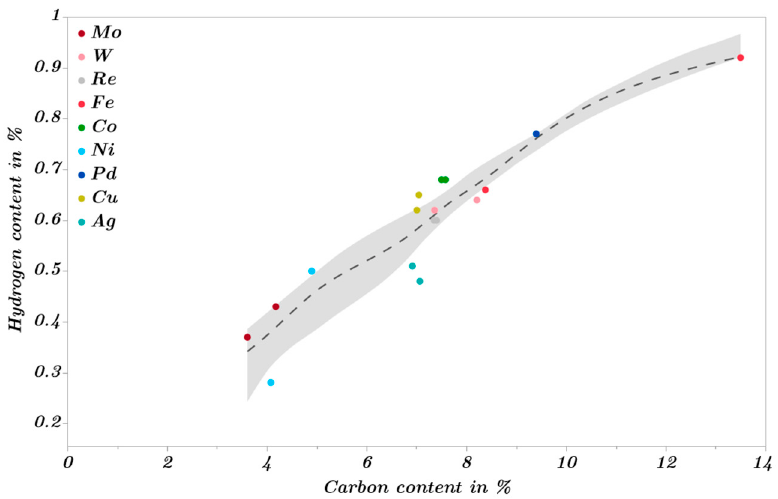
Figure 22. Dependence of the hydrogen and carbon mass fractions determined by CHNS analysis. The dashed smoothing is based on a spline with λ = 0.05.